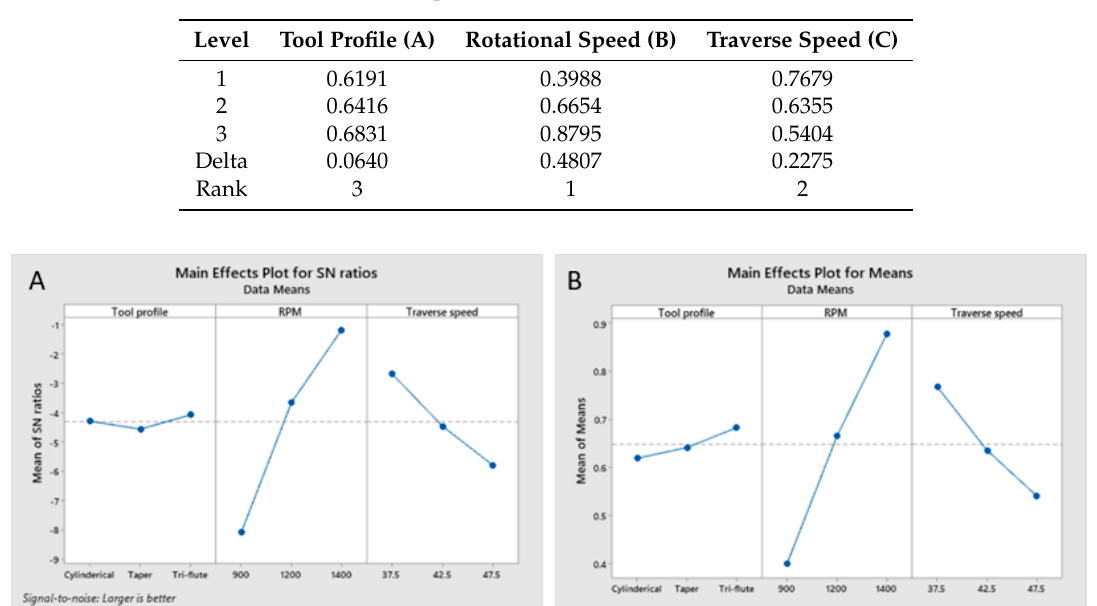
Table 16. Response table of main e ff ects for GRG.